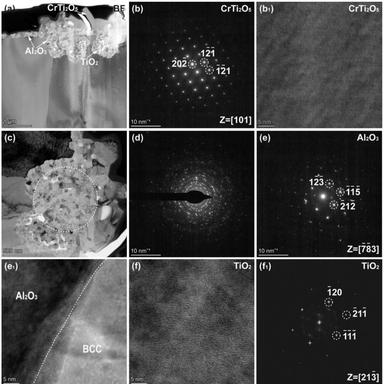
Phase structure of the oxide scale of Al12 CCA after 100 h oxidation at 800 ◦C in air identified by TEM analysis: (a) HAADF image, (b, b1) HR-TEM and corresponding to the SAED pattern of CrTi2O5, (c) Bright field (BF) image, (d) The SAED pattern corresponding to the white dashed line in Fig. 7c, showing the nano grain morphology, (e, e1) HR-TEM and SAED pattern shows the Al2O3 oxides, (f, f1) HR-TEM and corresponding to the FFT pattern of TiO2.